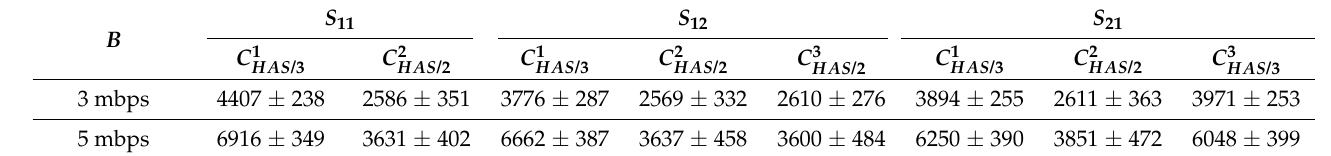
Table 6. The average number of cwnd updates of each client running the general ABR.